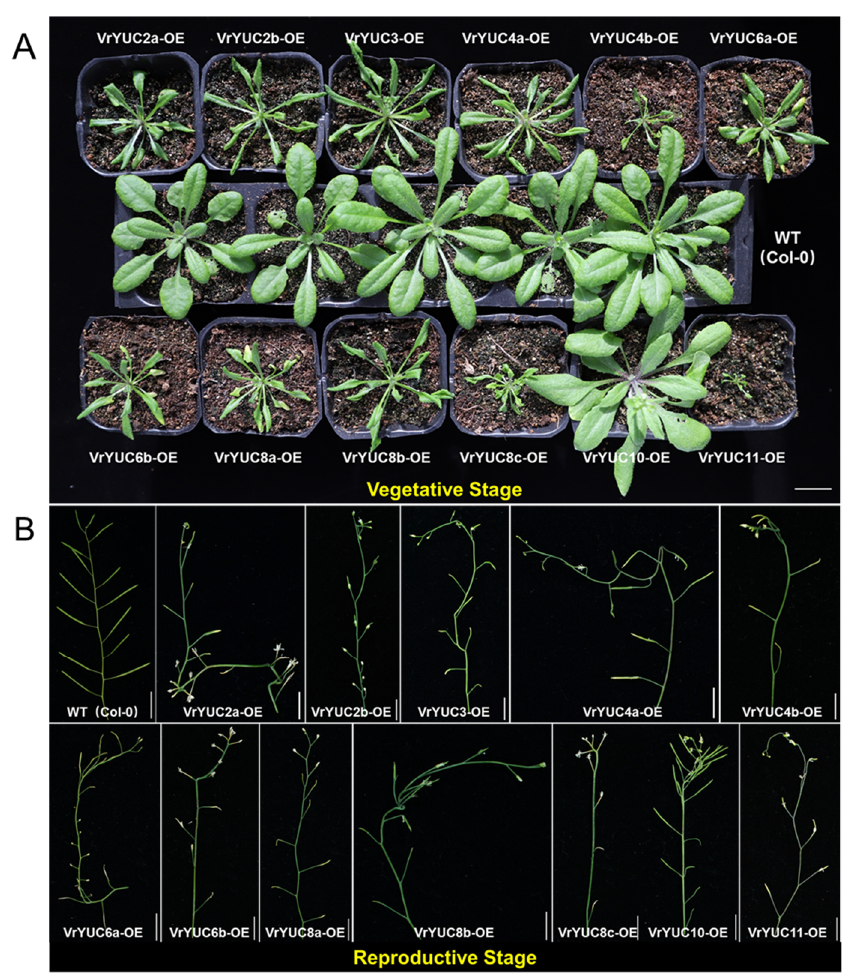
Figure 5. The phenotypic analysis of 35S:: VrYUCCAs transgentic Arabidopsis during vegetative period ( A ) and reproductive growth stage ( B ). OE: overexpression line. Bar = 1 cm.